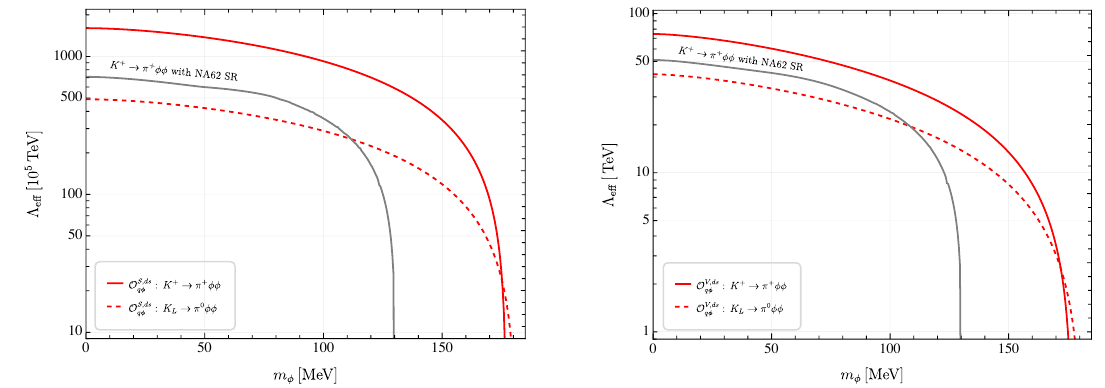
and O V,ds aφ aφ